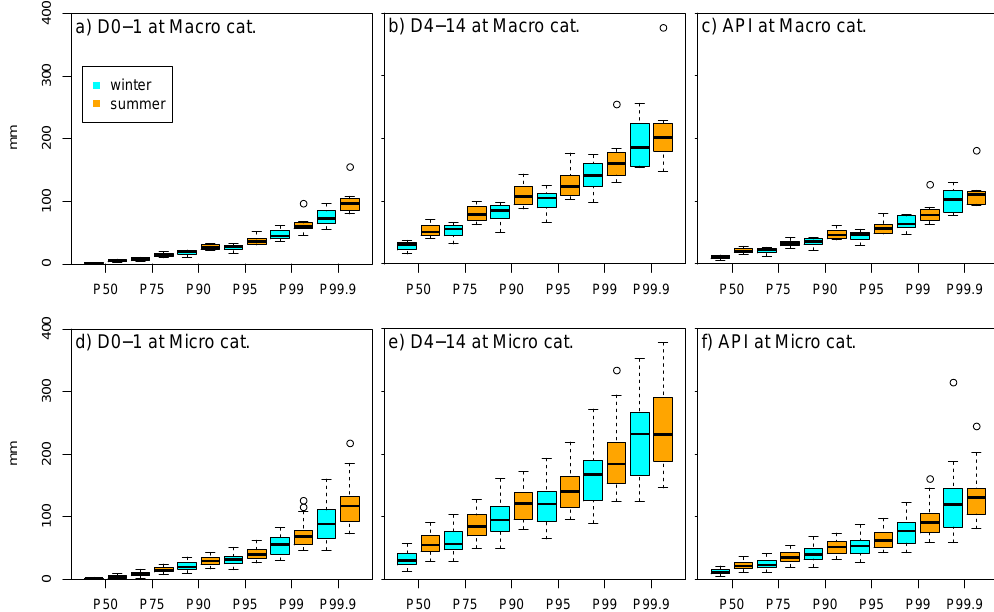
Figure 3. Absolute values of the climatological percentiles for the different PAPs. Statistics from Macro (a–c) and Micro (d–f) catchments are shown on the top and bottom row, respectively. Accumulations over 2 days which correspond to the PAPs D0–1 or D2–3 are shown in (a, d) . Accumulations over 11 days corresponding to D4–14 are shown in (b, e) . APIs are shown in (c, f) . Variation between catchments is visualized in